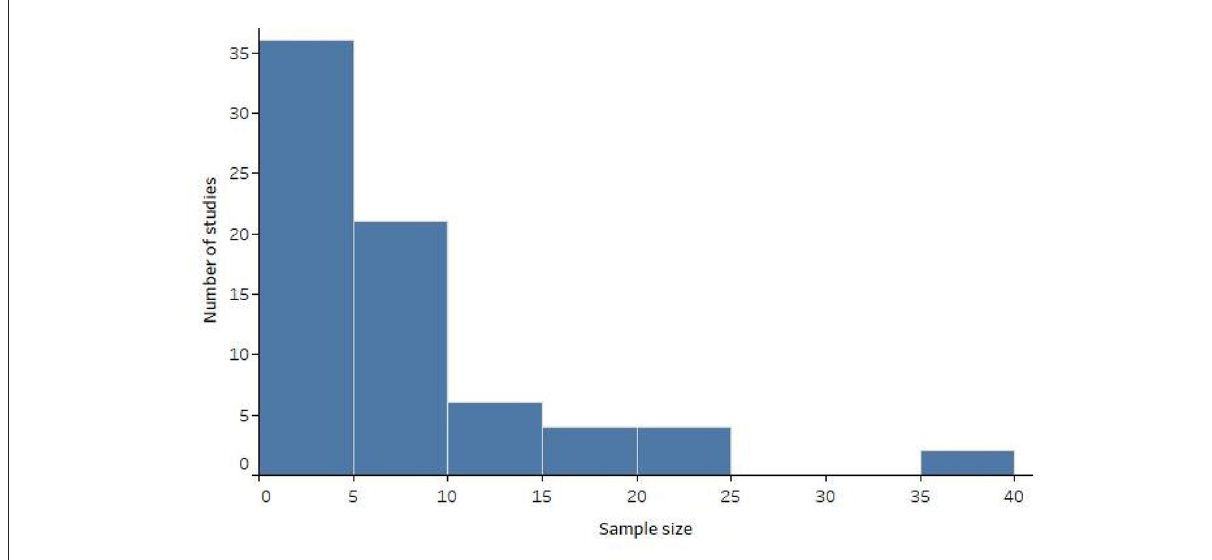
FIGURE3 Distribution of study sample sizes for participants with